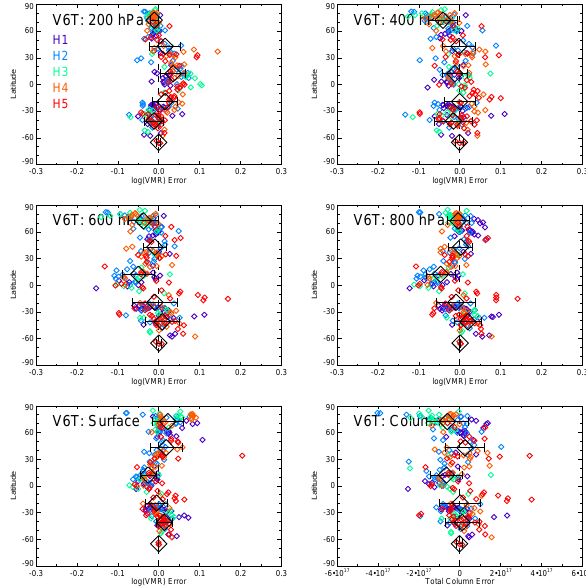
Figure 8. Time series plot showing V6 NIR-only (V6N) bias trends based on NOAA profiles.